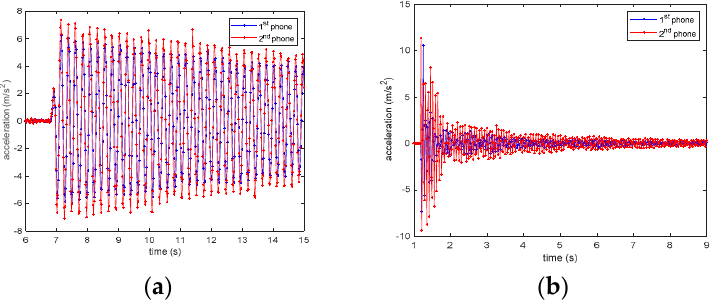
Figure 17. Smartphones’ measured structural responses in the test: ( a ) beam length = 60 cm; ( b ) beam length = 20 cm.